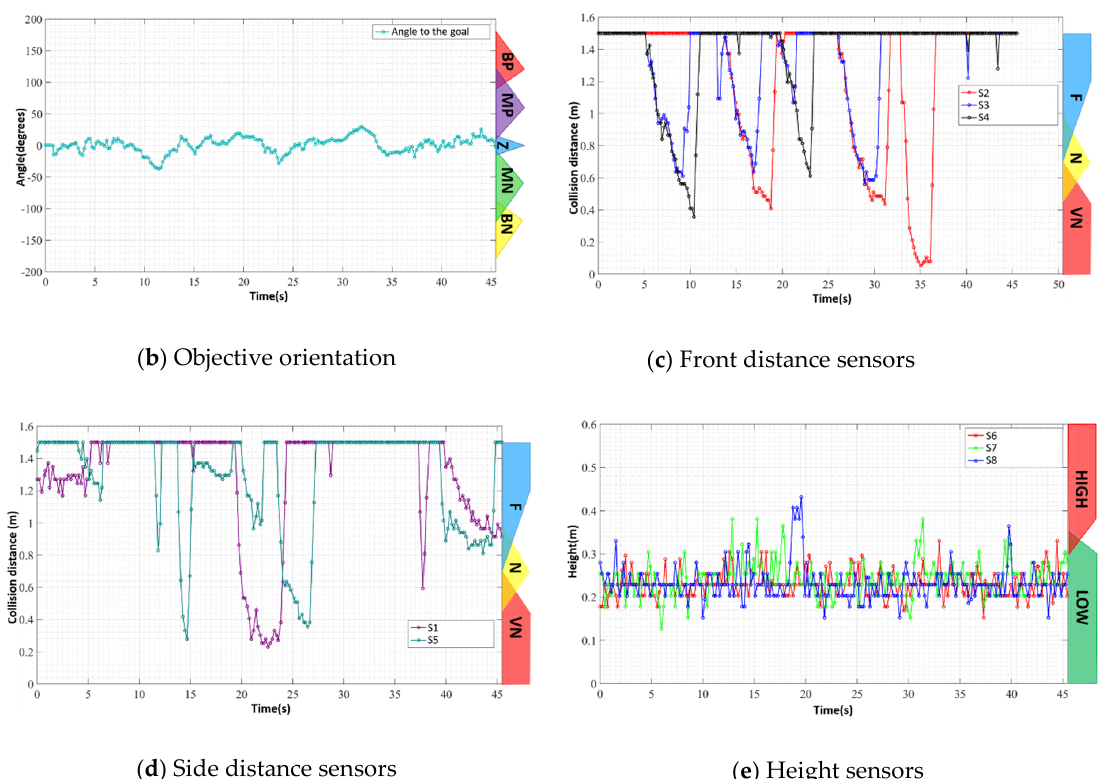
Figure 23. Sensor and actuator data during route 3.